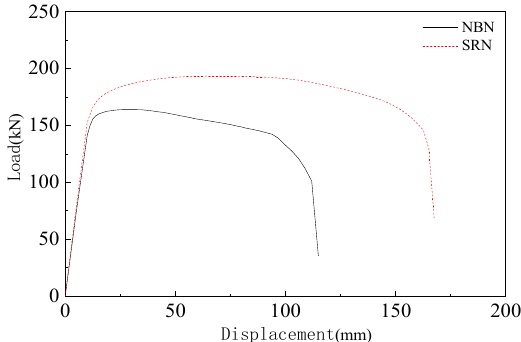
Figure 9. Load–displacement curves.